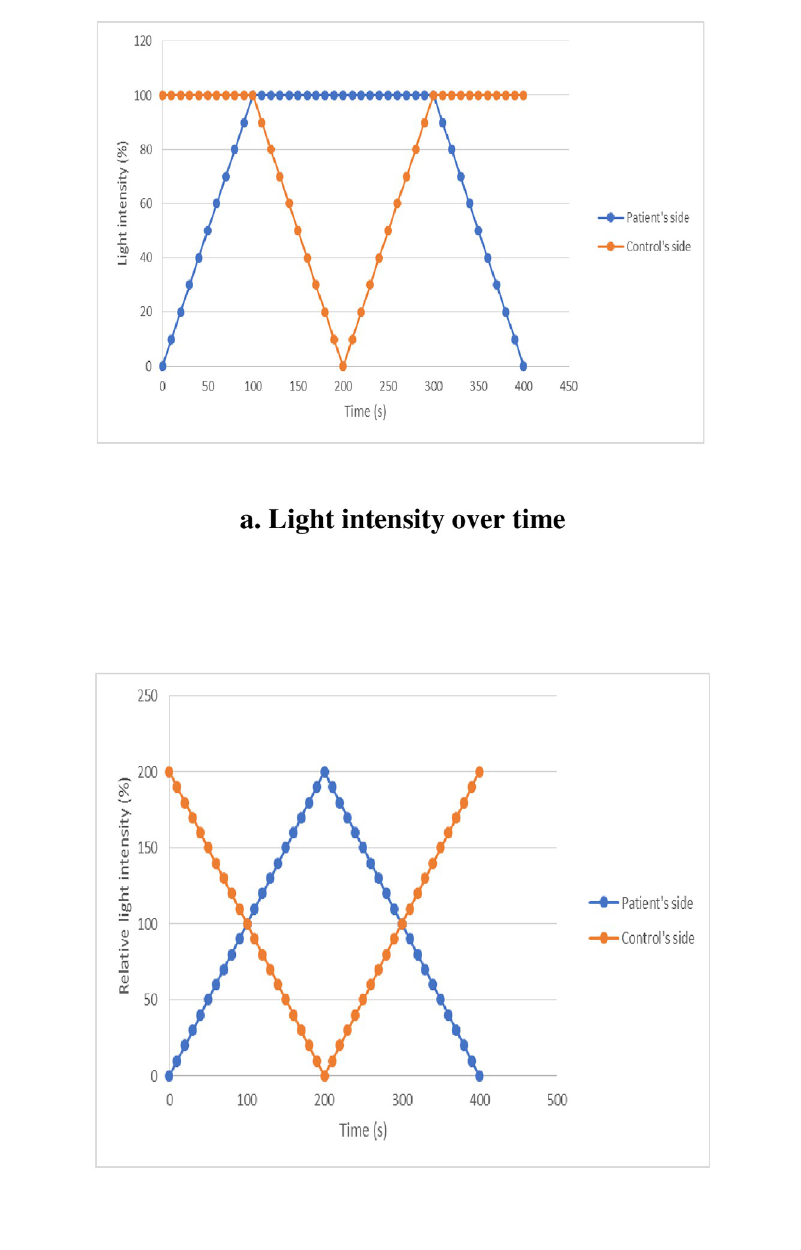
Fig 2. Simultaneous alterations in light intensity on each side of the mirror over time. a. Light intensity over time. At the beginning of the procedure, the light intensity was 100% for the TDCs (mirror effect), whereas the light intensity was 0% for the ASD patients (transparent window effect). Then, the light intensity is progressively increased in 10% steps on the ASD patient’s side while remaining at 100% for the TDCs until 100% is reached on both sides. During this first step, the ASD patient’s image progressively appears and becomes increasingly fused with the TDC’s image. When both sides are at 100%, the light intensity is progressively decreased in 10% steps on the TDC’s side, while it remains at 100% on the ASD patient’s side. During this step, the TDC’s image progressively fades until its total disappearance when the light intensity drops to 0%. Then, the reverse procedure is used to return to the initial configuration (100% on the TDC’s side, i.e., a mirror effect for the TDCs, and 0% on the ASD patient’s side, i.e., transparent window effect for the ASD patients). Therefore, a condition with identical light intensities is presented twice to the participants during this sequence called one “passage back and forth”. b. Relative light intensity perceived by each participant over time. Relative light intensity perceived by the participants taking into account that modifications of light intensity on one side modifies its reflective properties on both